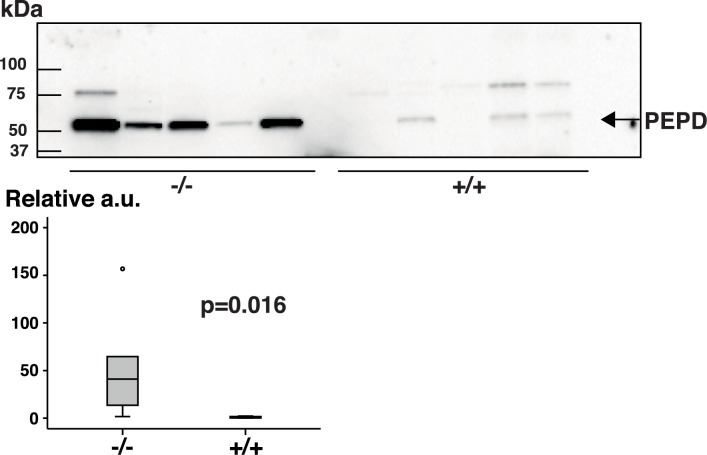
Immunoblots of peptidase D.A new set of fecal protein samples from Galphai2-/- mice and healthy littermates were subjected to immunoblotting for detection of peptidase D. Equal amounts of fecal protein were loaded from five Galphai2-/- mice at different stages of colitis. The first two lanes (from left) were from 4-week-old pre-symptomatic mice whereas lanes 3‒5 were from 7-, 10-, and 7-week-old mice with manifest colitis. Healthy mice were all 4 weeks old at the time of sample collection. The boxplot show densitometric quantitation of blots where peptidase D levels of Galphai2-/- mice were depicted relative to the mean value of the healthy wild-type littermates. a.u. = arbitrary units.